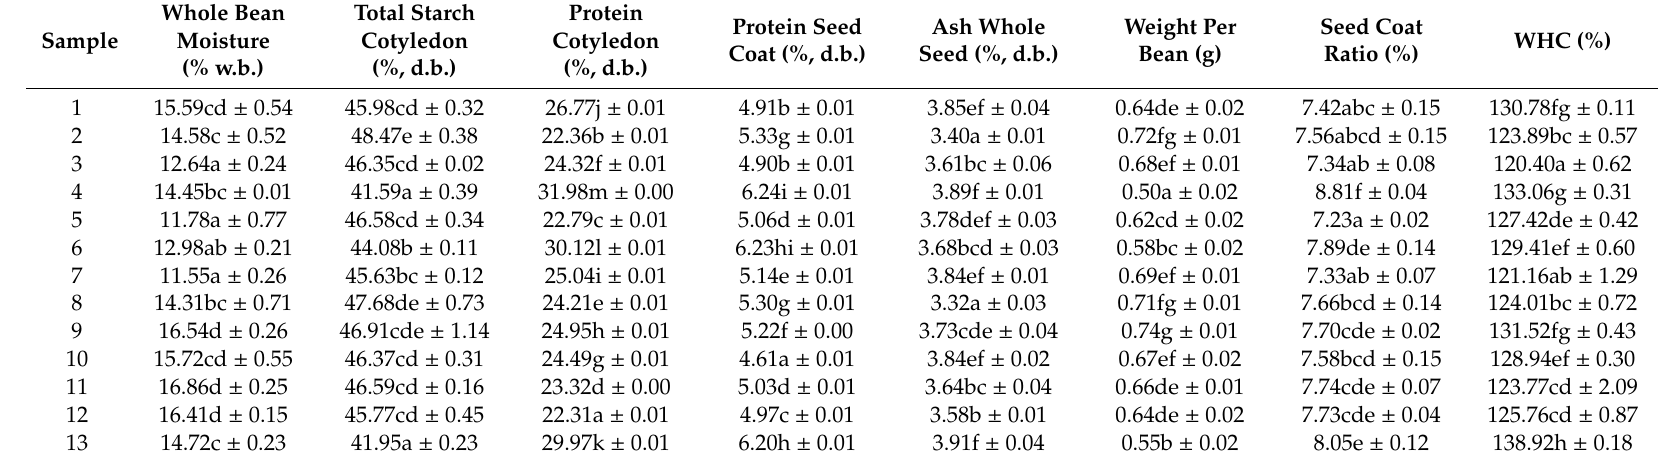
Table 2. Proximate analysis results of 13 red kidney bean